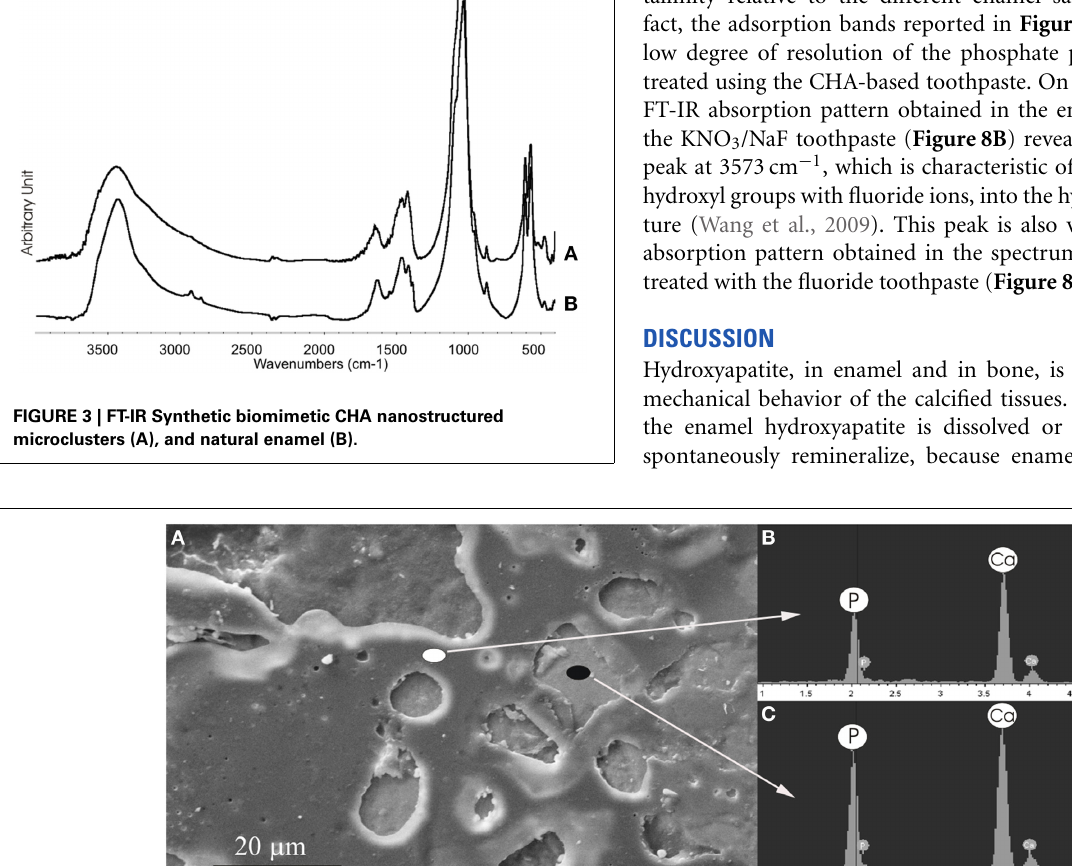
Frontiers in Physiology | Craniofacial